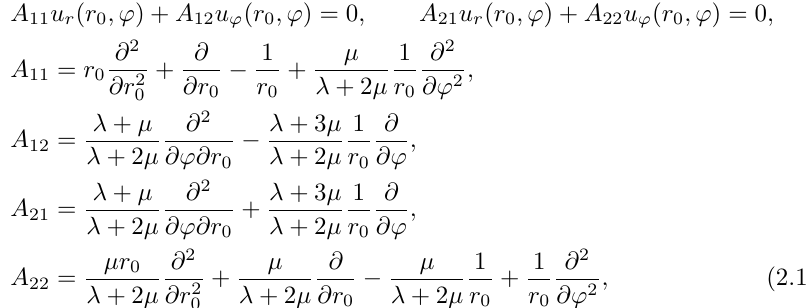
Figure 2. Positions of tooth root in sectional plane before and after displacement on magnitude of u 0 : 1 – external contour of PDL fixed on dental alveolus surface; 2 – position of cross-section of tooth root before acting load; 3 – position of cross-section of tooth root after load application; u 0 – displacement tooth root in 0 1 x 1 -axis direction; ϕ – polar angle. A 11 u r ( r 0 , ϕ ) + A 12 u ϕ ( r 0 , ϕ ) = 0